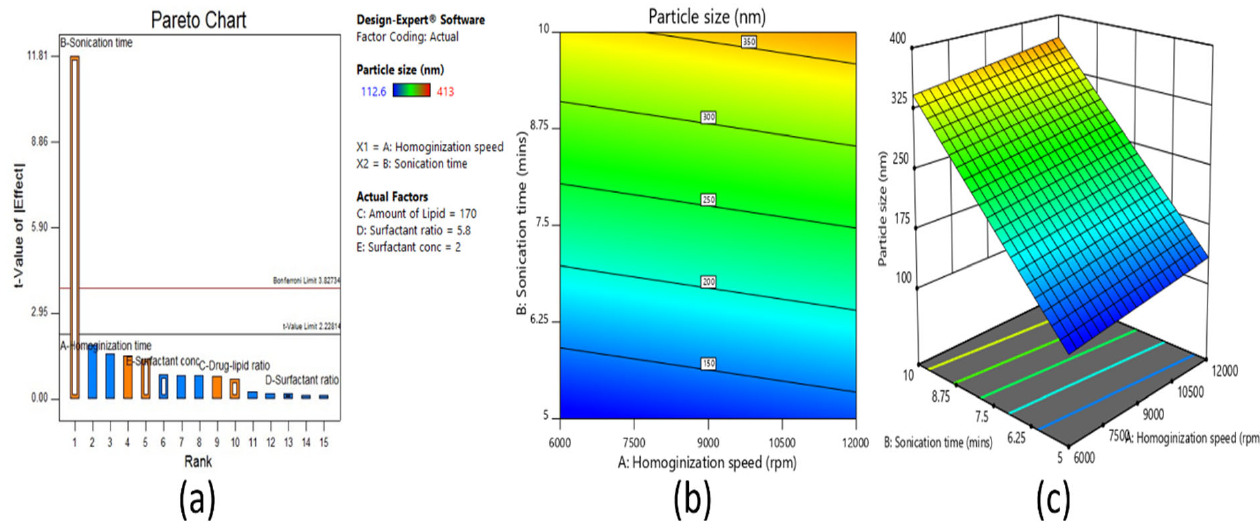
Figure 2. Pareto chart ( a ), contour plot ( b ), and 3D surface plot ( c ) representing the effect on particle size of fractional factorial design.